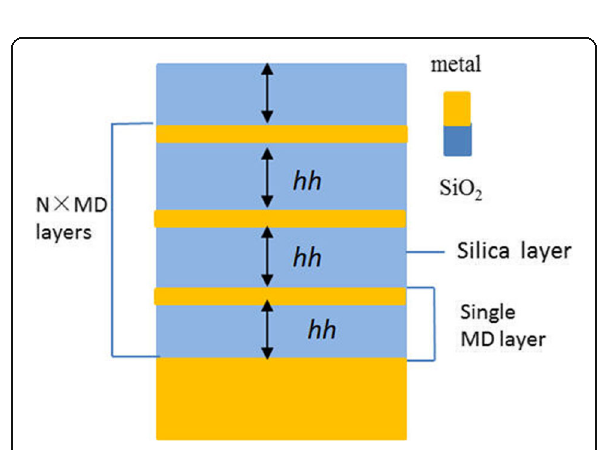
Fig. 7 Diagram of flat metal-dielectric multilayer absorber